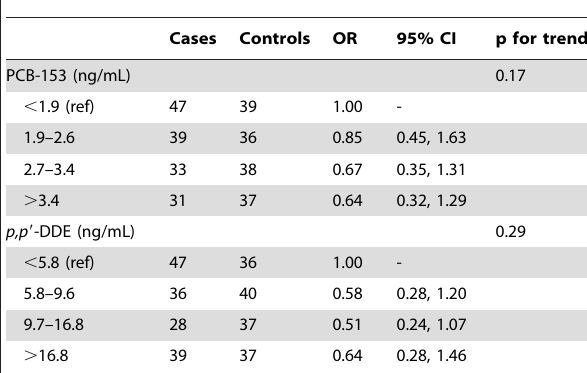
Table 2. Maternal serum concentrations of PCB-153 and p,p 9 - DDE at delivery, and the risk for developing type 1 diabetes among their